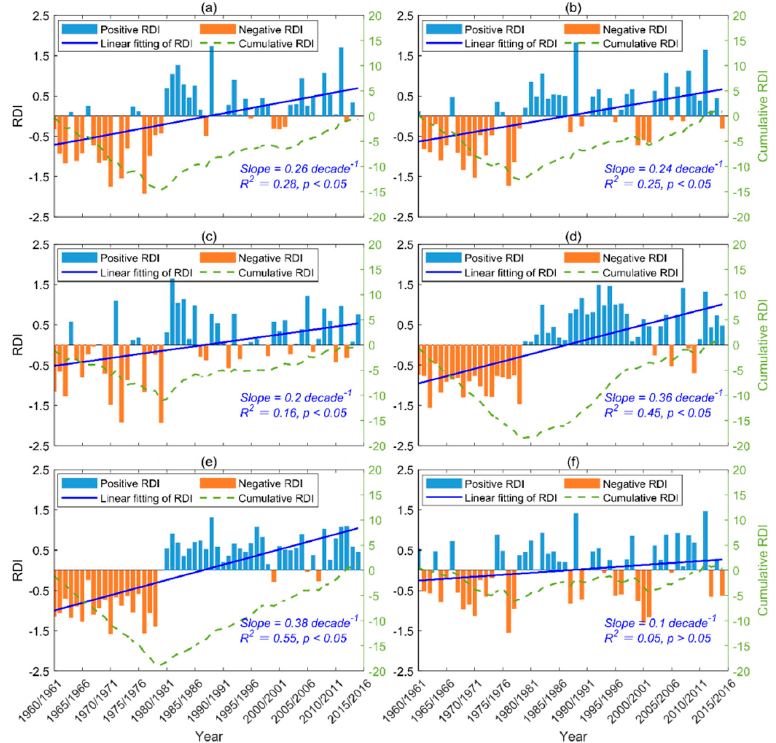
Figure 5. Time series and change trends of RDI at ( a ) annual, ( b ) vegetation growing seasonal (VGS) and ( c – f ) seasonal scales during 1960–2015: ( c ) autumn, ( d ) winter, ( e ) spring and ( f ) summer. On the seasonal scales (Figure 5c–f), RDI showed an increasing trend in autumn, win- ter and spring, but a slight and non-significant increasing trend in the summer. Among the four seasons, the change rate of RDI in spring was the largest, with a value of 0.38 decade − 1 , followed by that in winter (0.36 decade − 1 ) and autumn (0.2 decade − 1 ), and the smallest is in summer (0.1 decade − 1 ). In terms of the stability of RDI variations, although RDI showed an increasing trend on seasonal scales, its interannual variation and fluctua- tion characteristics varied greatly in different seasons. In winter and spring, RDI changed significantly from drought to wetness, with the turning point of 1979/1980. Since the turn- ing point, SRYRB has been in a wet state almost all the time in these two seasons. How- ever, in autumn and summer, the fluctuation between drought and wetness is obvious, especially in summer. 3.3. Variation Characteristics of Drought and Wetness Events 3.3.1. Intra-Annual Variation Characteristics of Drought and Wetness Events As presented in Figure 6 and Table 4, the frequency of droughts was high before 1980, including mainly the mild droughts. Among 240 months during 1960–1980, there were 149 months, 40 months and 10 months undergoing mild, moderate and severe drought, respectively. Additionally, there was one month showing extreme drought in June 1966. As for wetness events, there were only five months and one month experiencing moder- ately and severely wetness ones, respectively. Therefore, these observations suggest that SRYRB was mainly dominated by the drought before 1979/1980. However, since 1980/1981, drought frequency decreased significantly. Among 420 months during 1981– 2015, only 114 months, 7 months and 2 months underwent mild, moderate and severe drought, respectively, with no extreme drought.